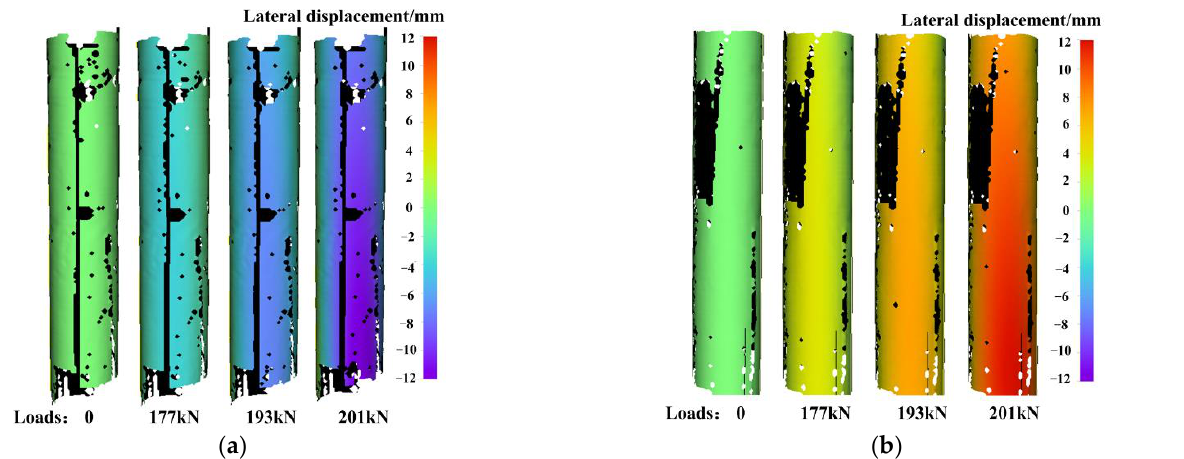
Figure 22. Displacement evolution on: ( a ) concave side; ( b ) convex side under different axial loads. Correspondingly, MC-DIC can also obtain the full-circle strain field, the strain evolu- tion on the concave and convex sides under different axial loads are shown in Figure 23a,b, respectively. First, the compressive strain on the column surface gradually increases with the loading. Secondly, the compressive strain around the column is not evenly dis- tributed, the concave side undergoes a larger compressive strain than the convex side. The concave surface finally has a strain value up to about 5000 με , while the convex surface has a maximum strain value of around 2500 με . It should be noted that the data with larger errors at the lower end of the column are not taken into consideration. During the meas- urement, to avoid the speckles in AOI from being arbitrarily blocked, all the dangling wires of strain gauges are gathered together along a line (see in Figures 16 and 17) and concentrated to the lower end. Besides, the speckle range is larger than the AOI to ensure enough valid data. Thus, the speckle spraying quality at the edges away from the mid- span is relatively poor. All above results in the local large-error area in the lower edge. ( a ) ( b ) Figure 23. Strain evolution on: ( a ) concave side; ( b ) convex side under different axial loads.